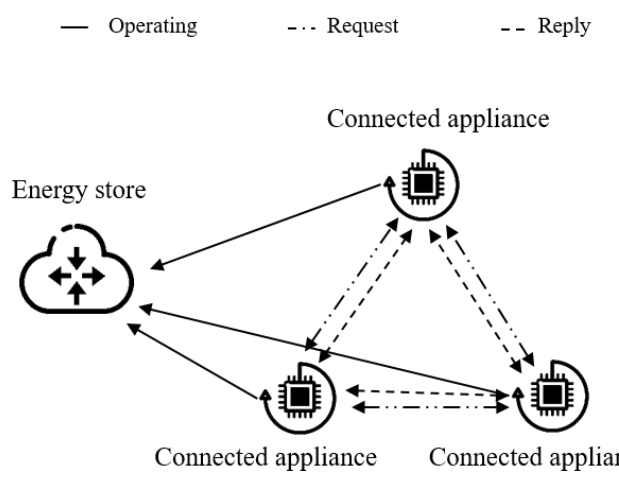
Figure 7. Consensual negotiation process for connected